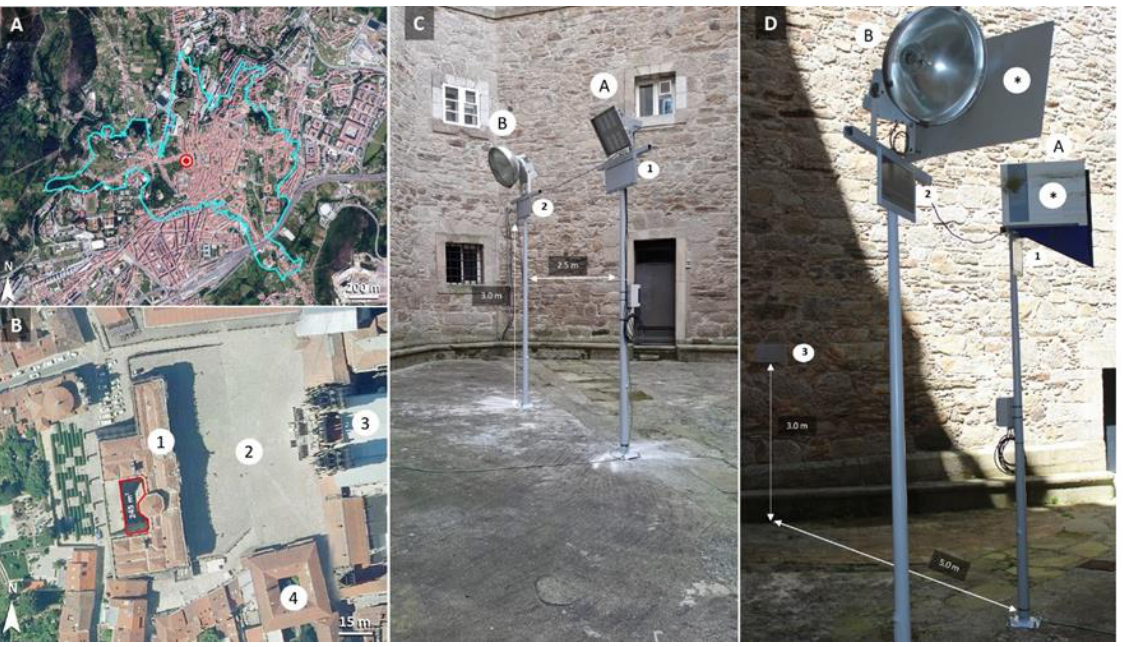
Figure 2. Experimental layout. ( A ) Overview of the historical centre of Santiago de Compostela (outlined in blue) and the location of the study site (red point). ( B ) Study site, inner courtyard (outlined in red), 1: Pazo de Raxoi (city council buildings), 2: Praza do Obradoiro (Obradoiro Square), 3: Cathedral of Santiago de Compostela, 4: Colexio de San Xerome (a university building). ( C , D ) Experimental set-up details in the inner courtyard. A: CromaLux light, B: Metal halide lamp (positive control). 1: location of the insect trap beside the CromaLux lamp, 2: location of the insect trap beside the metal halide lamp, 3: location of the insect trap in the unilluminated area. *: sheets used to prevent interference between both light systems. Aerial photographs from PNOA 2020 © CNIG. Table 1. Sampling (clustered in five similar time periods) carried out between 1 June and 20 October 2021 and corresponding meteorological data, extracted from METEOGALICIA. Available online: